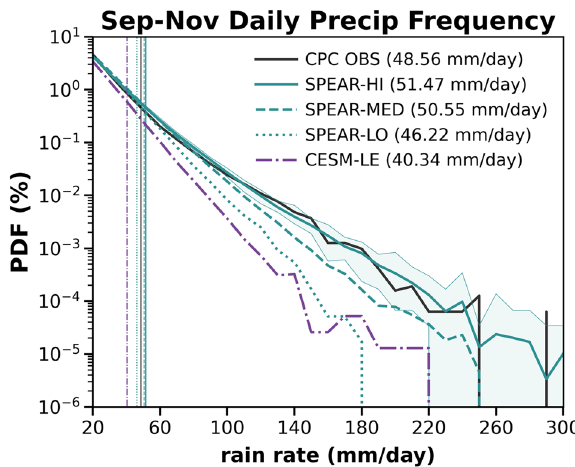
Fig. 1 Probability density function of daily precipitation over the NEUS in September to November during 1951 – 2020. The observation is shown by the black line. SPEAR_LO (100-km resolution), SPEAR_MED (50-km resolution), and SPEAR_HI (25-km resolution) simulations are shown in green dotted, dashed, and solid lines, respectively. CESM-LE (100-km resolution) is shown by the purple dash-dotted line. Only the spread of SPEAR_HI ensemble members is shown. The ensemble spreads for the other models are included in Supplementary Fig. 2. Vertical lines and the numbers shown in the legend indicate the thresholds of 99th percentile daily precipitation in each dataset or model (see “ Methods ” for the de fi